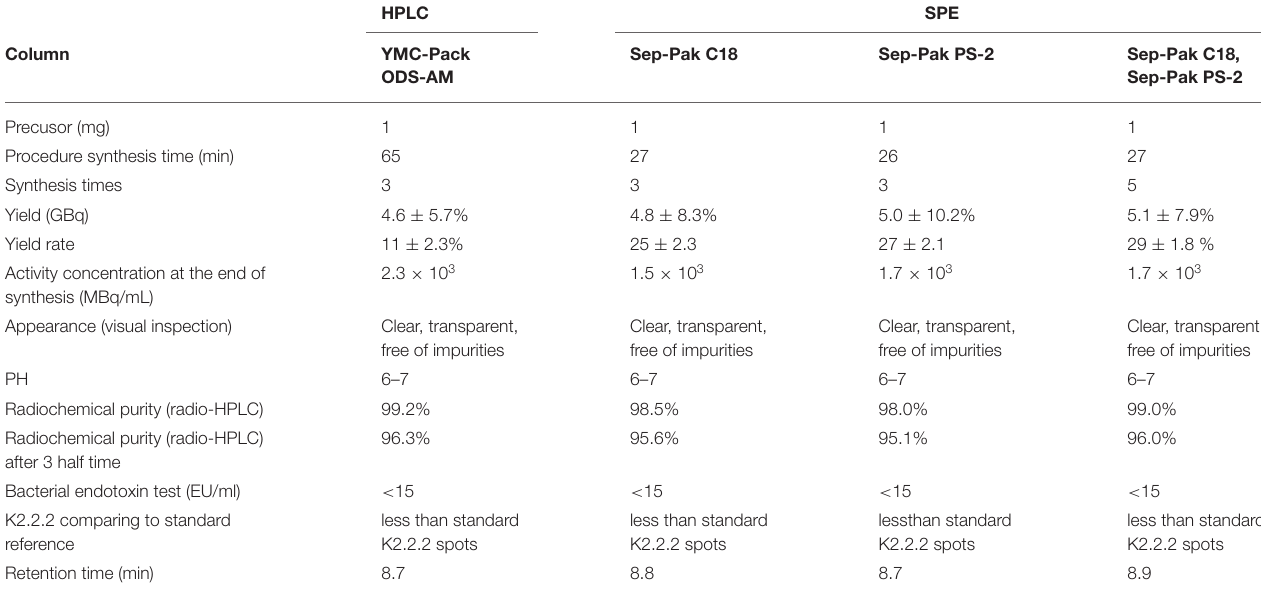
TABLE 1 | Comparison between HPLC and SPE purification of 18 F-FP-( + )-DTBZ.